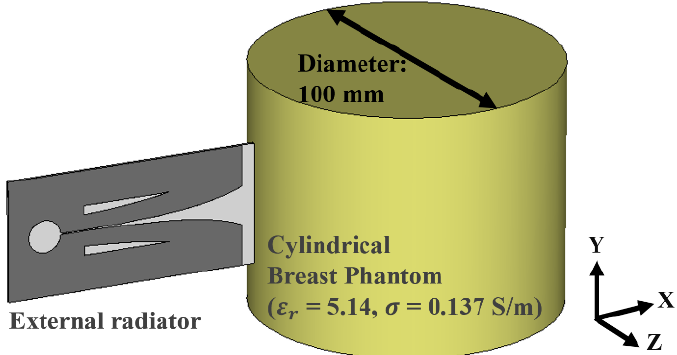
Figure 1. Configuration of the proposed system.